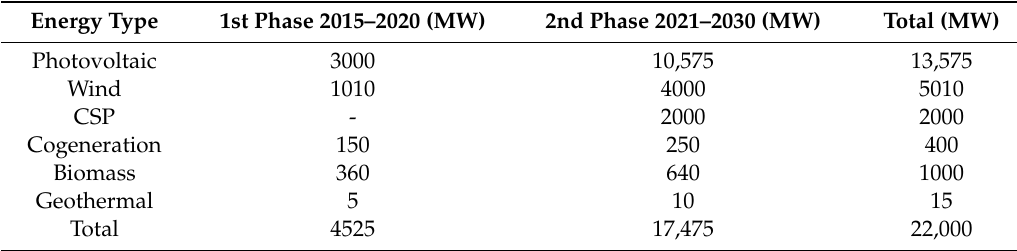
Table 2. Phases of the Algerian renewable energy program [58].